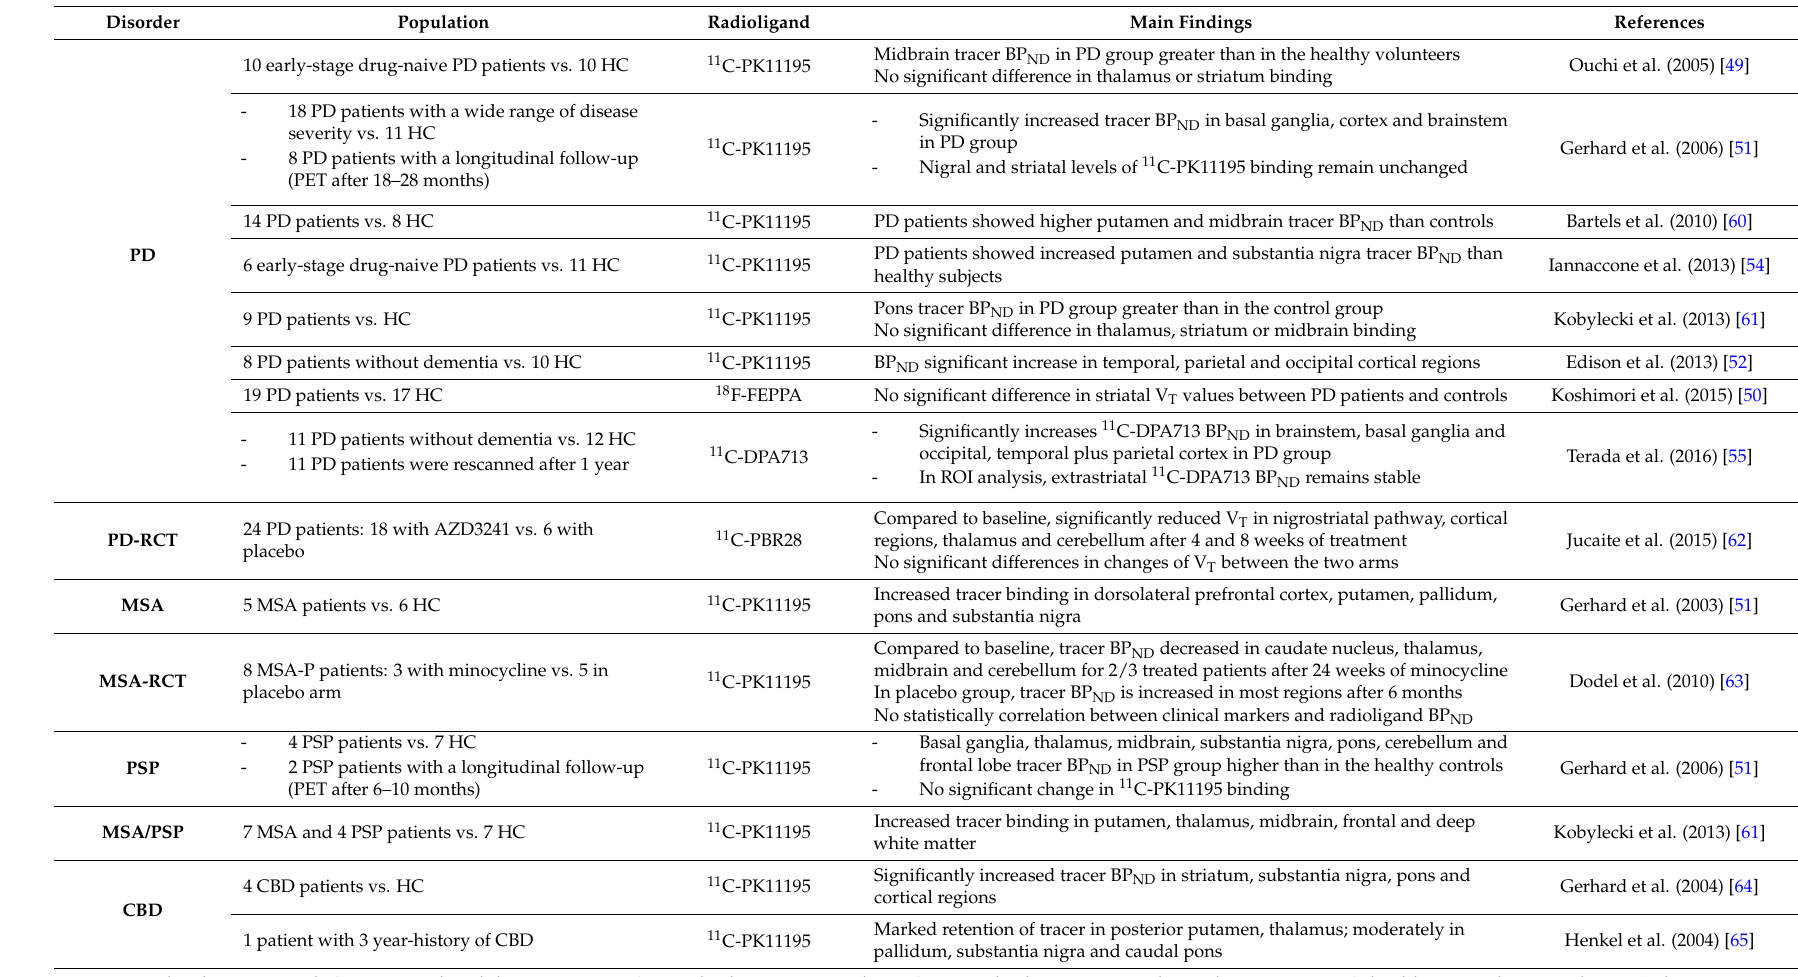
Table 2. PET imaging studies assessing TSPO tracers in parkinsonian